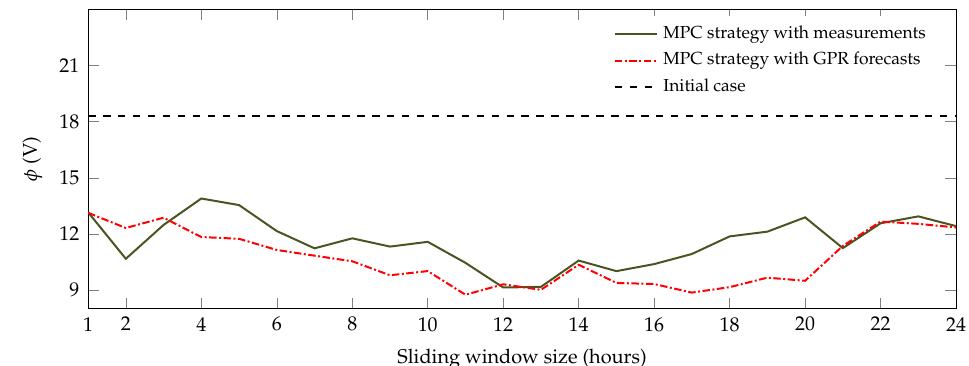
Figure 9. Average voltage overshooting per time step, with respect to the sliding window size used by the MPC